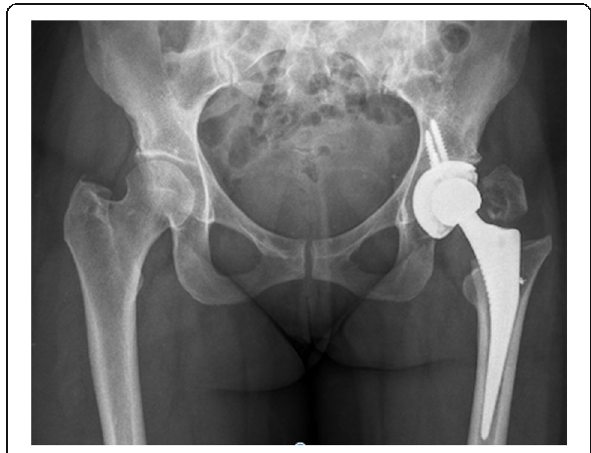
Fig. 4 X-ray of postoperative displacement of trochanteric fracture in the case of dysplastic hip